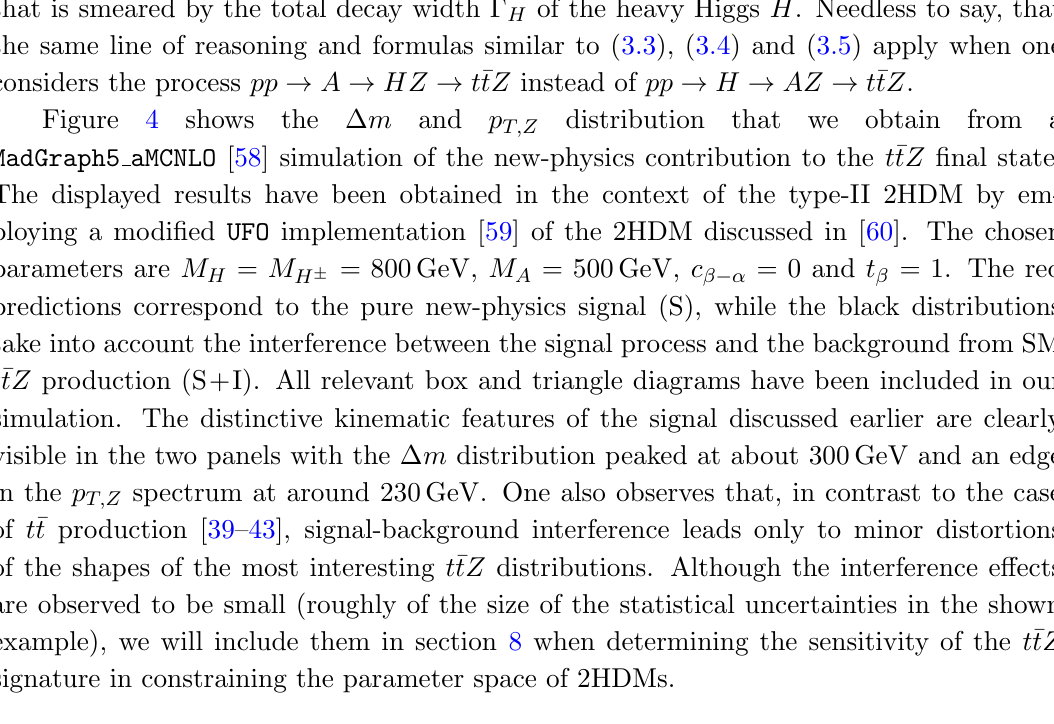
Figure 4 shows the (cid:1) m and p